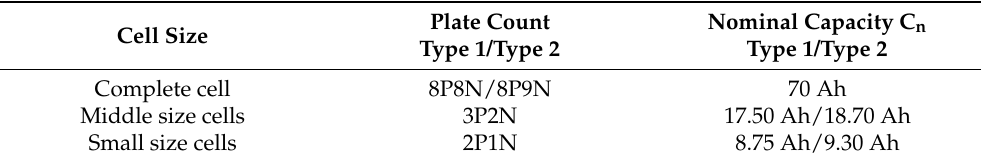
Table 1. Test cell setup and its nominal capacity, where P is the number of positive plates, and N is the number of negative plates (Reprinted from Ref. [16]).